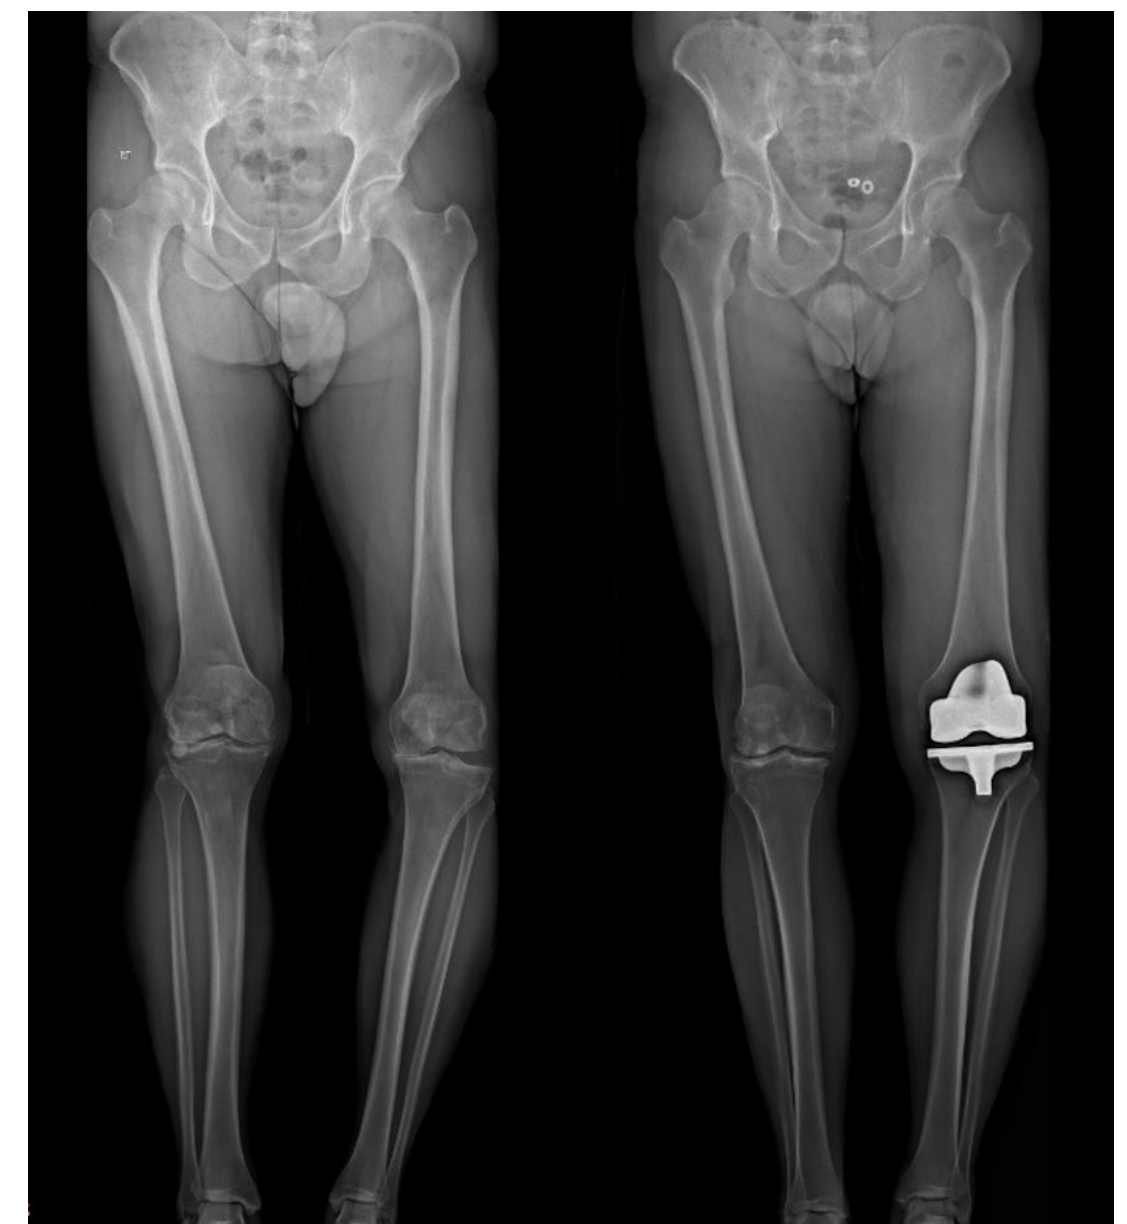
Figure 1. A 46-year-old man with a postoperative MPTA of 78°, LDFA of 86°, and HKA of